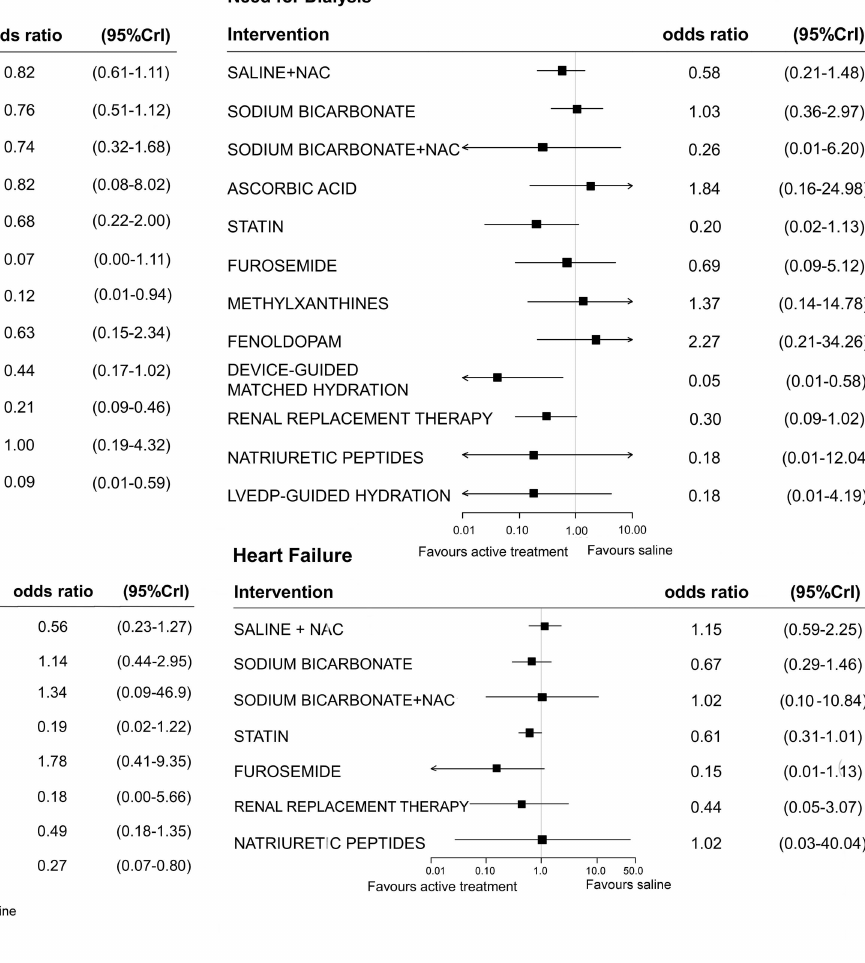
Fig 4. Forest plots for effect sizes of treatment strategies compared with saline, for mortality, dialysis, myocardial infarction and heart failure. Estimates are presented as odds ratios and 95% credible intervals (95% CrI). LVEDP = left ventricular end-diastolic pressure; NAC = N-acetylcysteine; * in severe chronic kidney